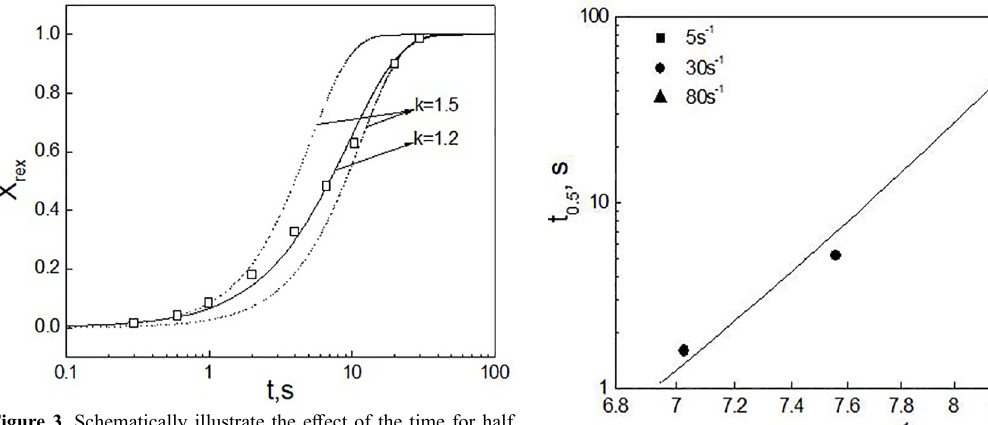
Figure 3. Schematically illustrate the effect of the time for half recrystallization on the value of k.